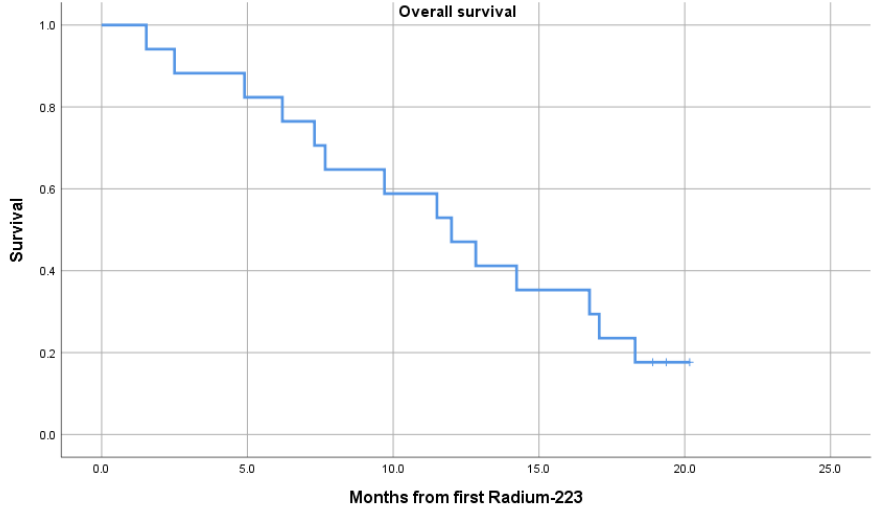
Figure 4. Kaplan-Meier curve of overall survival. Median OS 12 mo. (95% CI: 7.8–16.2).